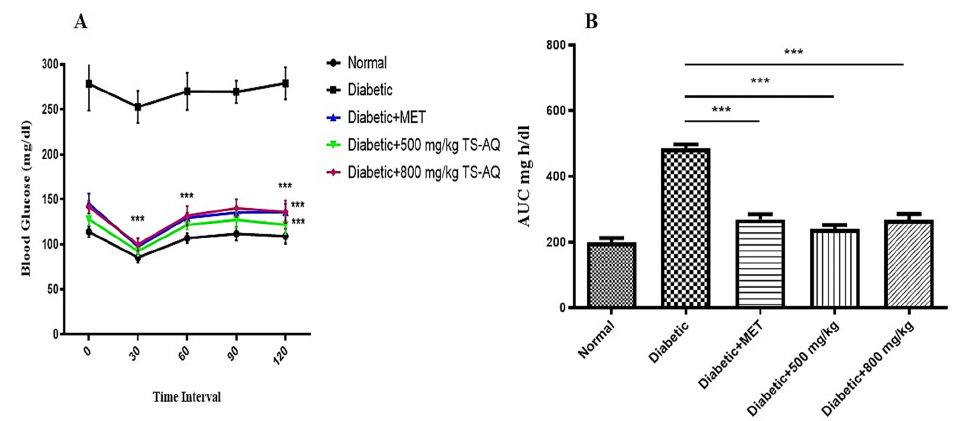
Figure 6. Insulin tolerance test. ( A ) Blood glucose levels were assessed after intraperitoneal injection of insulin (0.5 U/kg) at 30, 60, 90, and 120 min. Before injection, values were recorded for 0 min. ( B ) The AUC curve showing the glycemic index for each group. * Depict statistical significance. *** = p < 0.001. ( n = 10 for each group).